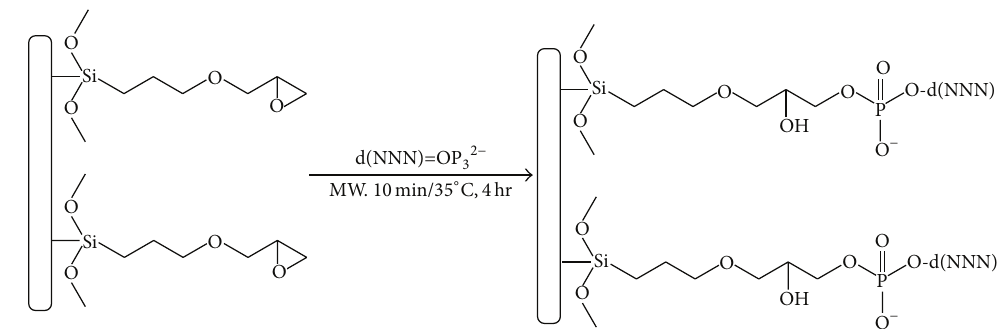
Scheme 2: Covalent attachment of phosphorylated